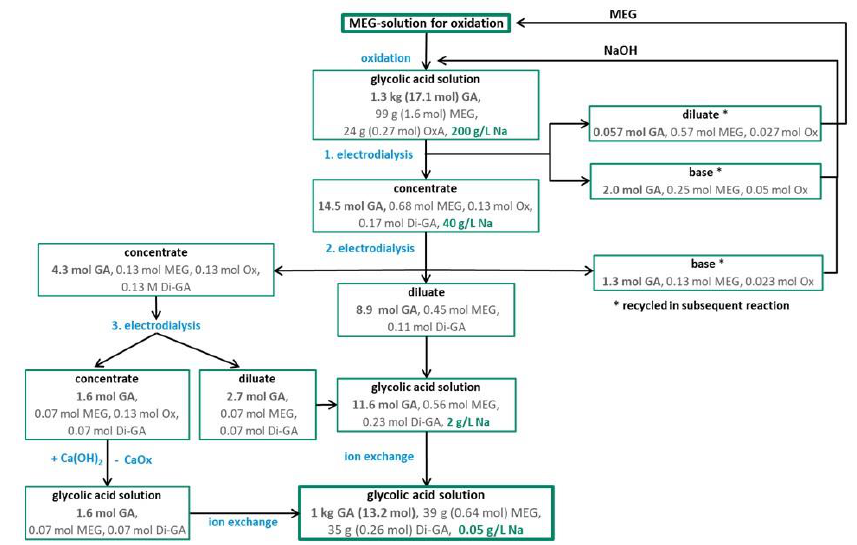
Figure 7. Scheme of the GA purification process.